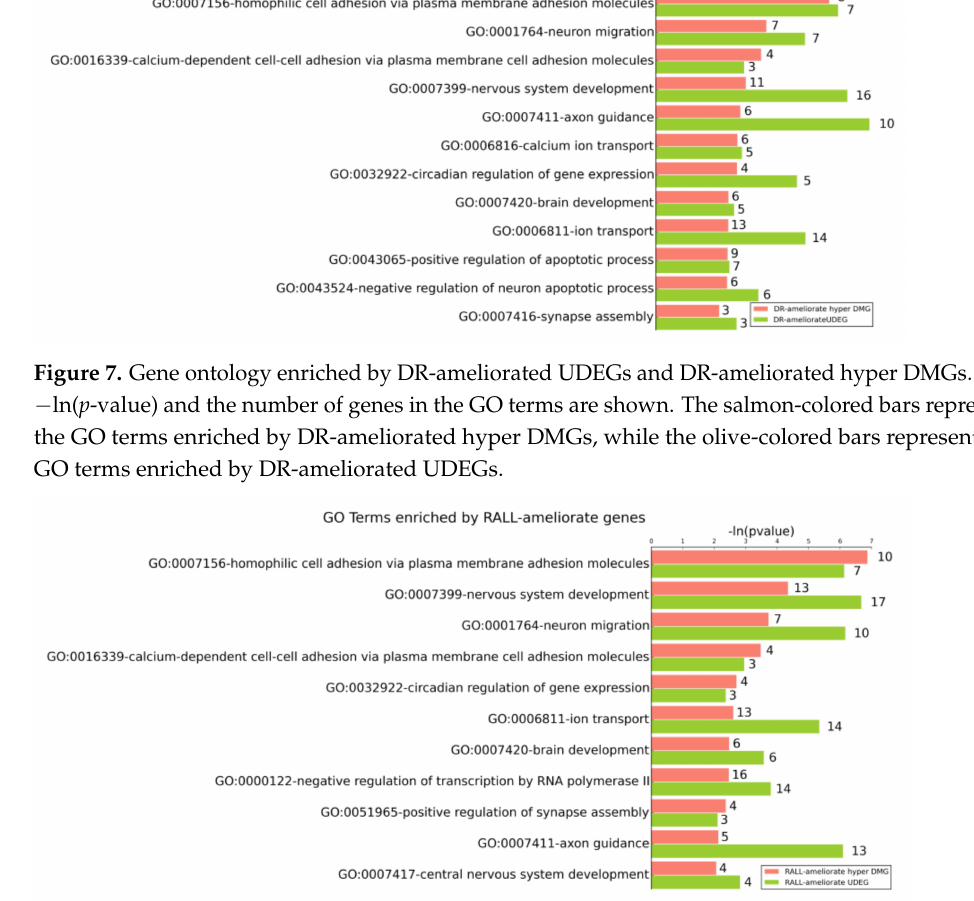
Figure 8. Gene ontology enriched by RALL-ameliorated UDEGs and RALL-ameliorated hyper DMGs. The − ln( p -value) and the number of genes in the GO terms are shown. The salmon-colored bars represent the GO terms enriched by RALL-ameliorated hyper DMGs, while the olive-colored bars represent the GO terms enriched by RALL-ameliorated